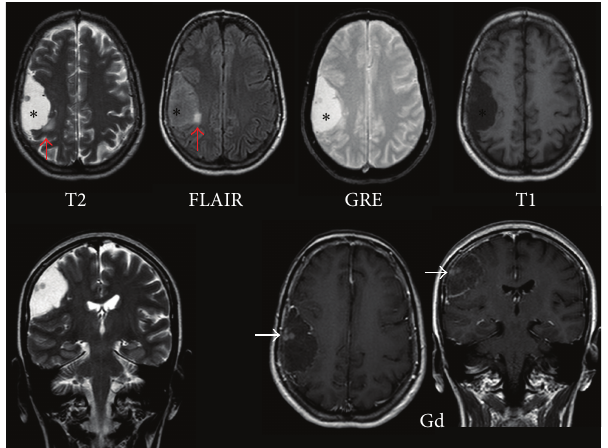
Figure 2: Gadolinium-enhanced brain MRI. The lesion is hypointense on T1- and hyperintense on T2-weighted images (asterisk). Signal intensity is high on FLAIR images probably due to the cyst protein content. A small mural nodule is observed. After gadolinium administration, enhancement of the small mural nodule (white arrow) and of the peripheral cystic area is observed. There is a small hyperintense area on T2-weighted and FLAIR images (red arrow) around the medial aspect of the cyst, probably related to the presence of reactive gliosis.